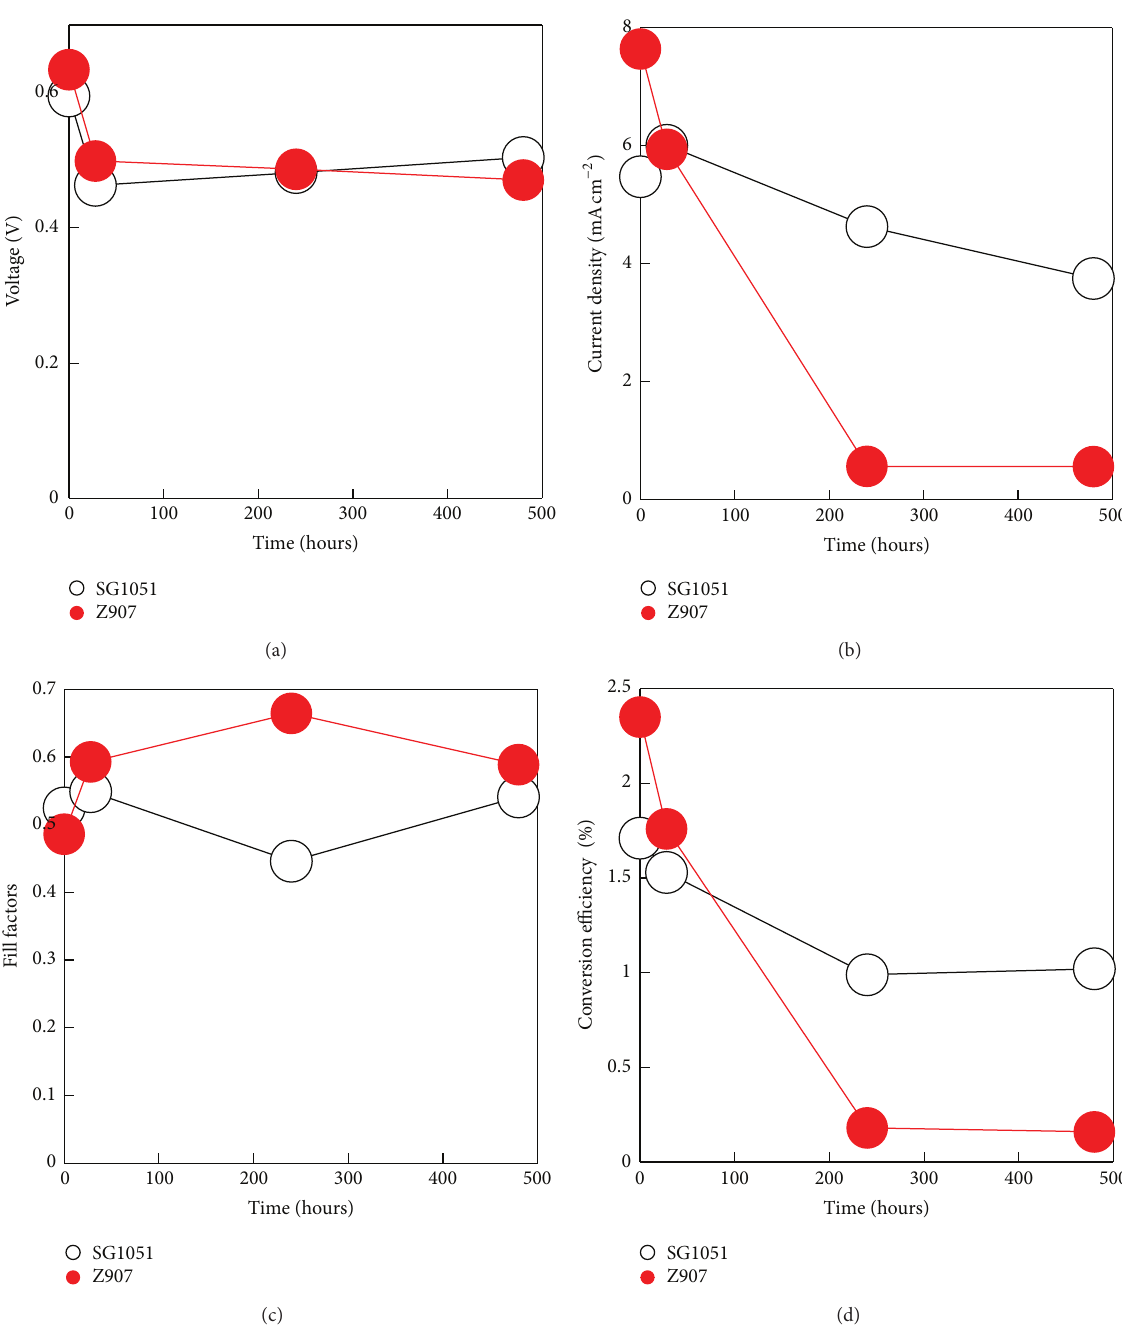
bond, the progress against such thermal stress test is due to the double